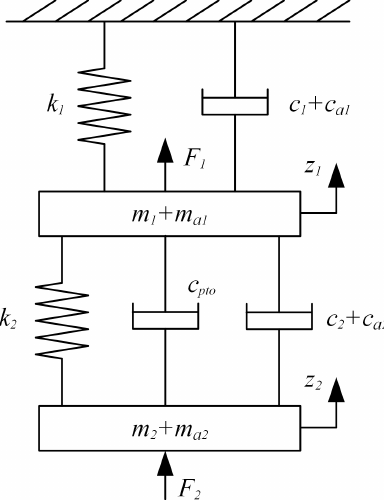
Figure 2. Dynamic model diagram of a multi-body heave wave en- ergy conversion